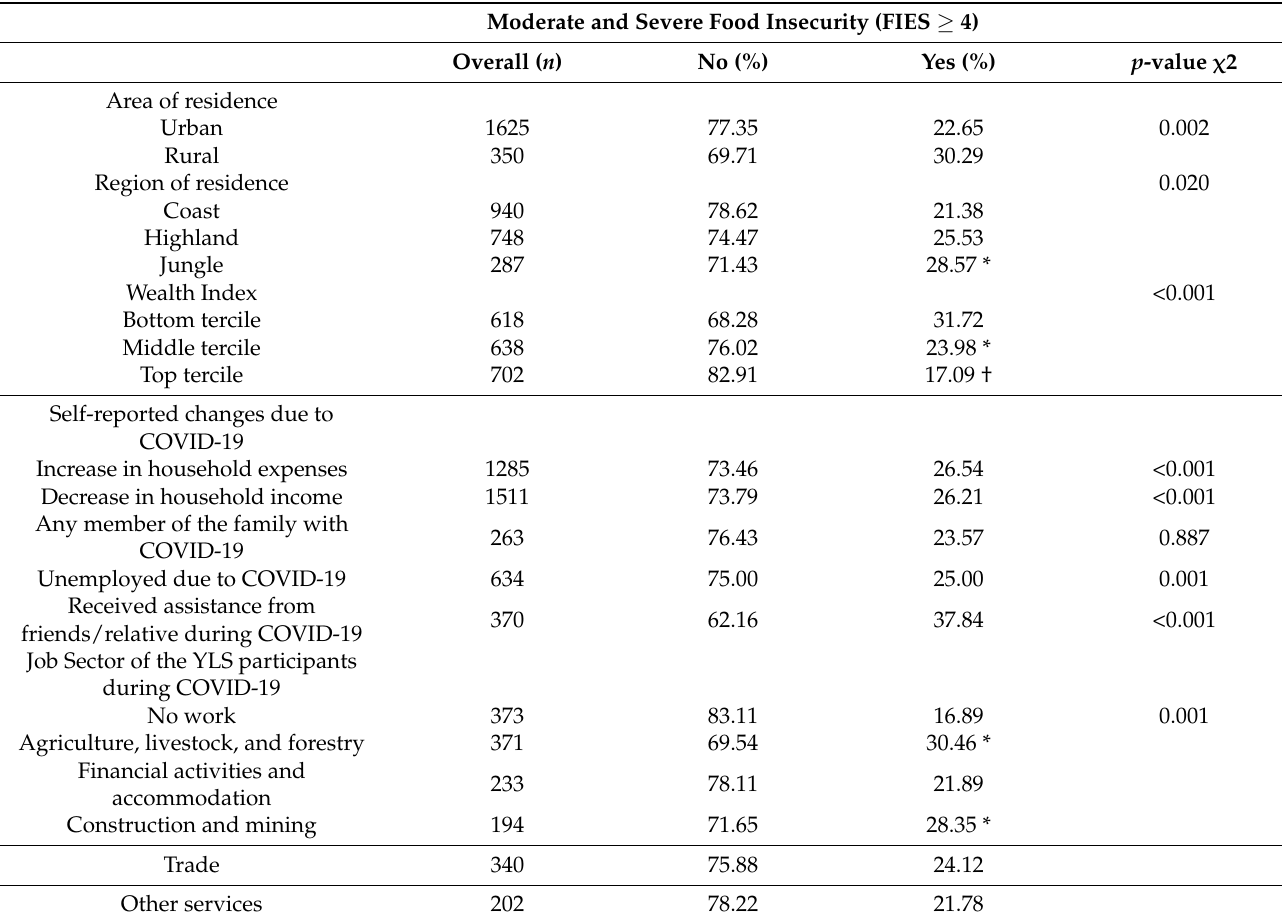
Table 2. Household characteristics and changes due to COVID-19 by food insecurity status in the YLS